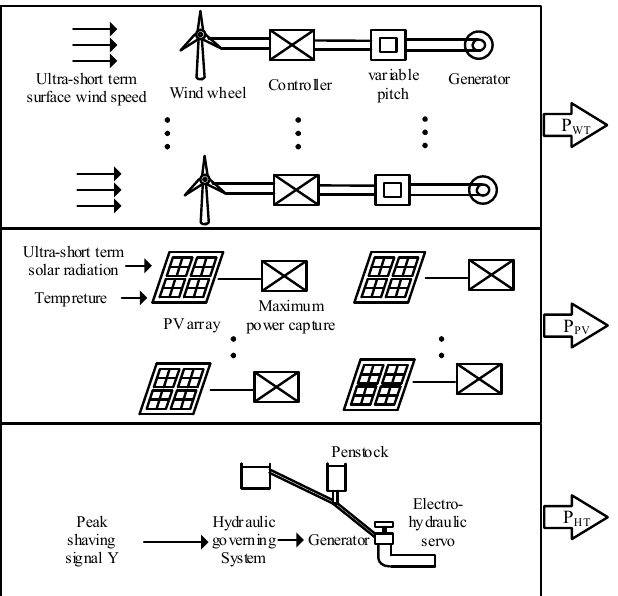
Figure 2. Sand-table deduction model.